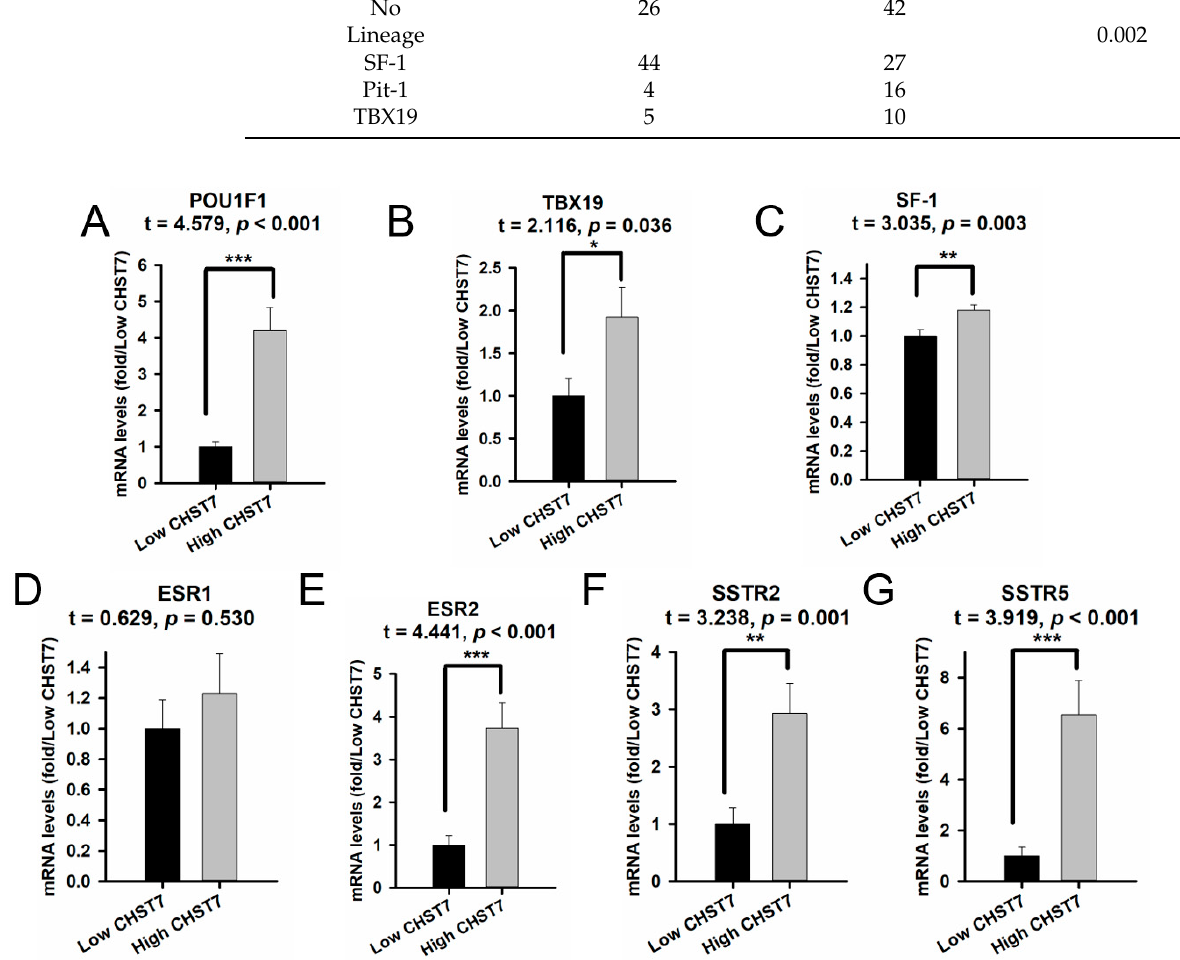
Figure 5. The mRNA levels of transcription factors and receptors compared with different mRNA levels of CHST7. ( A ) Pit-1; ( B ) TBX19; ( C ) SF-1; ( D ) ESR1; ( E ) ESR2; ( F ) SSTR2; ( G ) SSTR5. Compared to the low-CHST7 group: * p < 0.05; ** p < 0.01; *** p < 0.001.